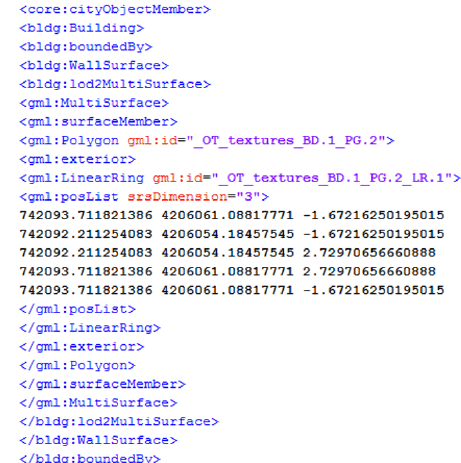
Figure 2. Part of the Exported CityGML File by SketchUp At the same time, a new empty database was created in PostgreSQL/PostGIS where the Coordinate Reference System (CRS) of the study area was defined and its schema was structured in the format of 3DCityDB using the Command Prompt/cmd.exe (see Figure 3). This schema includes 45 entities/tables (see Figure 5).